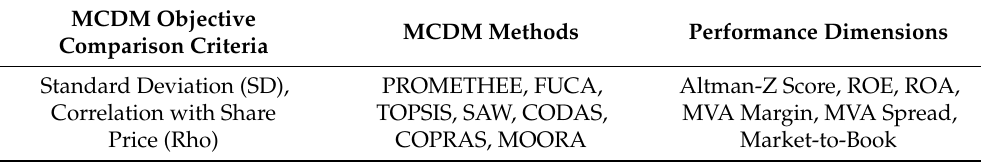
Table 1. MCDM Comparison Criteria, MCDM Methods, Performance Dimensions in This